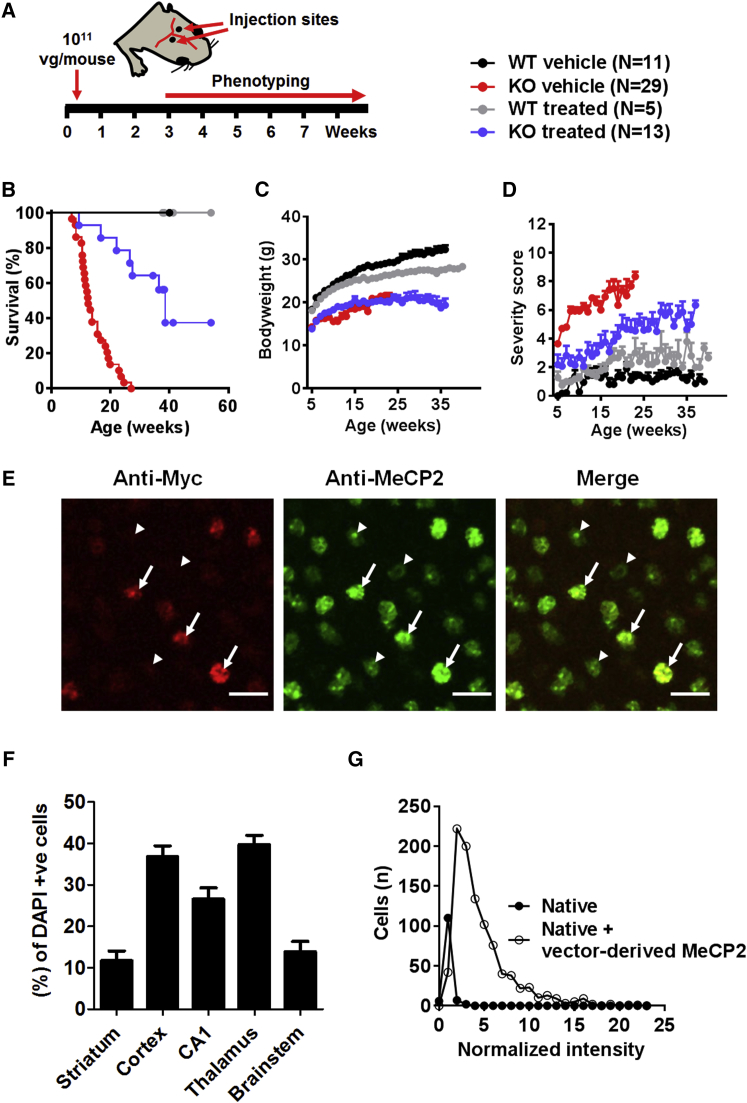
Direct Brain Delivery of Second-Generation Vector to Neonatal Mecp2−/y Mice Revealed Therapeutic Efficacy(A) Experimental design. KO, knockout. (B) Survival plot showing extended survival of neonatally treated Mecp2−/y mice (median survival = 38.6 weeks; p < 0.0001, Mantel-Cox test) compared with vehicle-treated animals (median survival = 12.4 weeks). (C and D) Plots showing mean (C) body weight and (D) aggregate severity scores, respectively, for the mice shown in (B). (E) Representative confocal images from the cortex of injected wild-type mice. White arrows indicate transduced cells; arrowheads indicate non-transduced cells; scale bars indicate 20 μm. (F) Graph showing transduction efficiency in different brain regions (n = 3 mice). (G) Frequency distribution of MeCP2 levels in transduced and non-transduced (“native”) cells in the mouse cortex (n = 3 mice; 954 transduced cells) data presented as mean ± SEM.